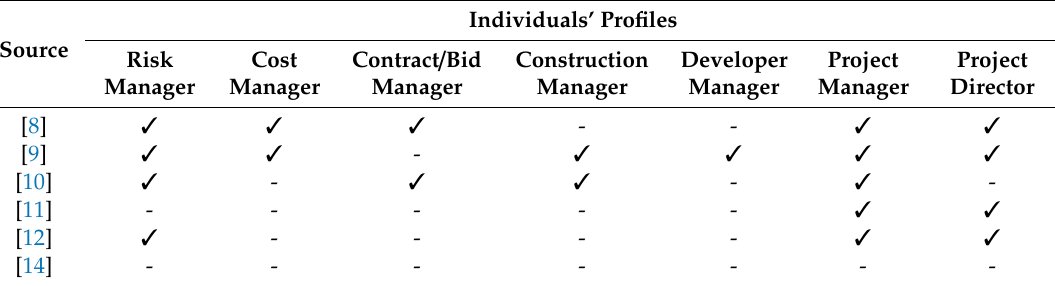
Table 5. Individuals’ profiles.